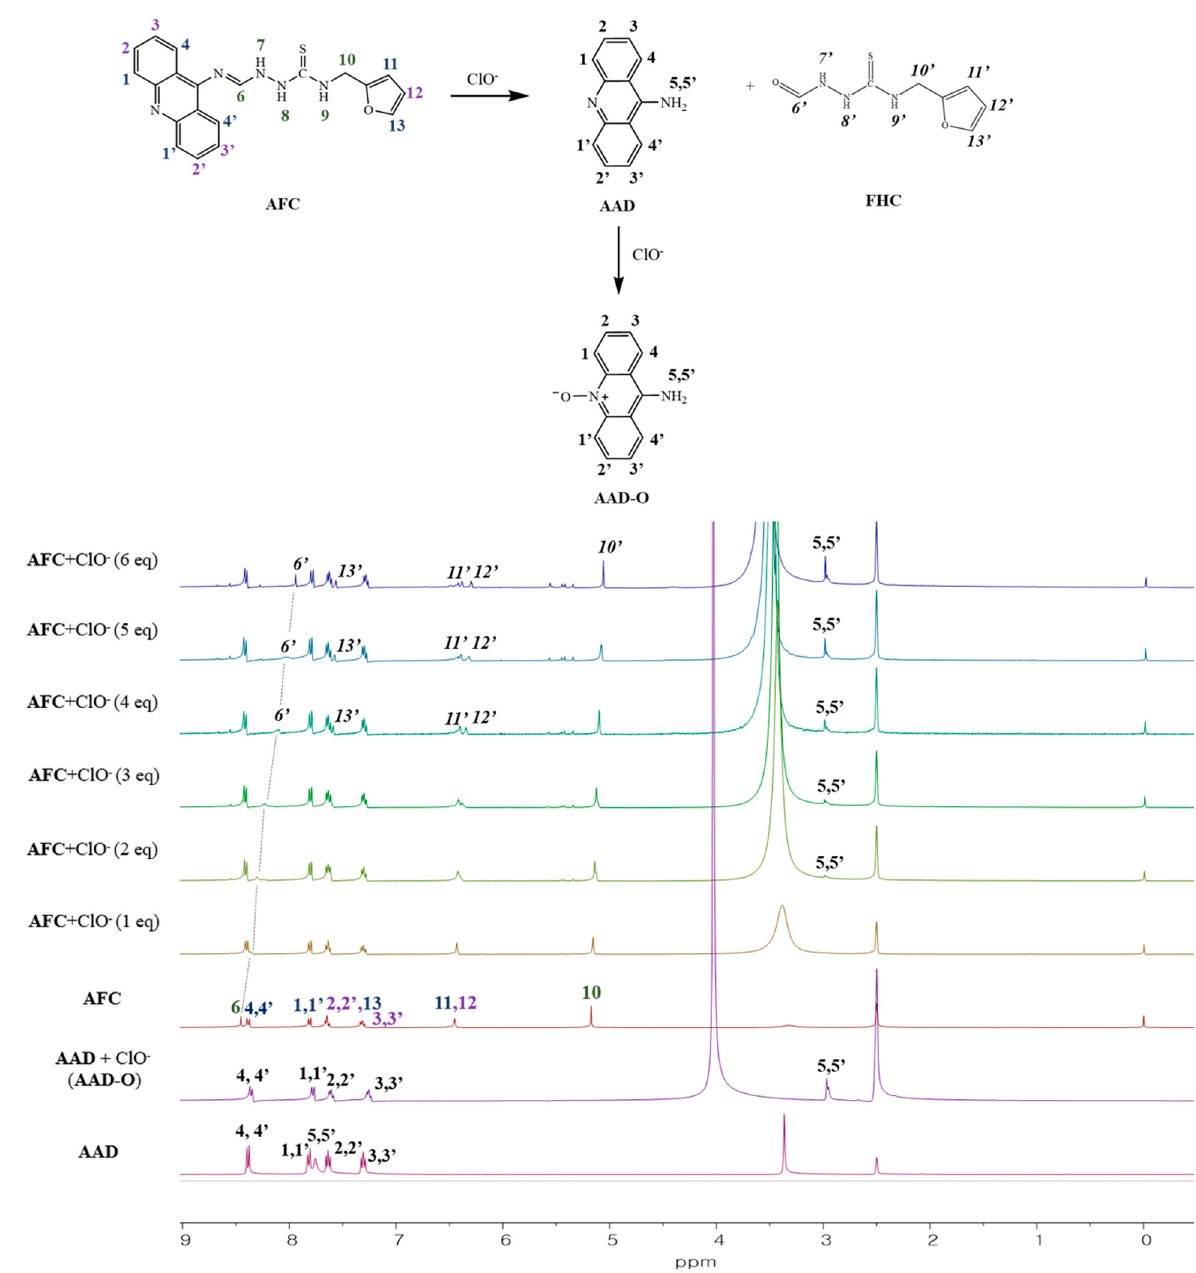
Figure 4. 1 H NMR titration of AFC with ClO − (DMSO- d 6 ).